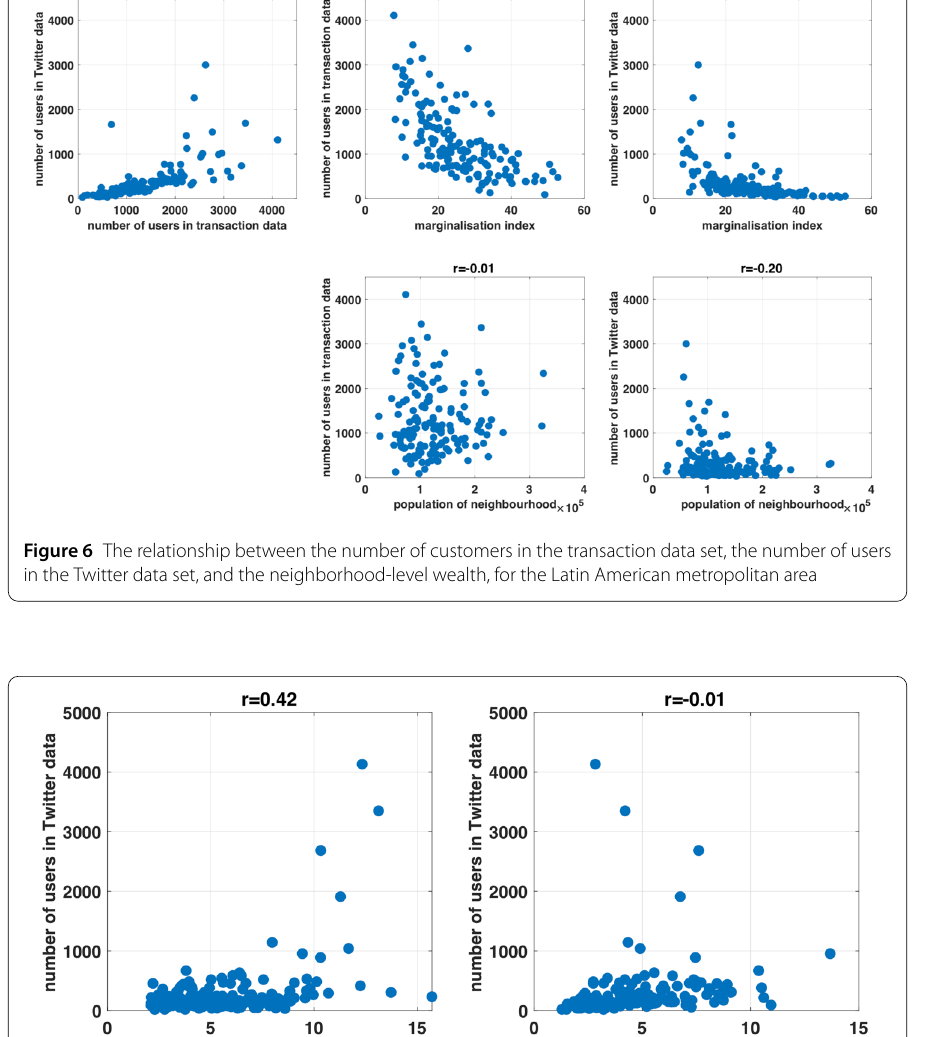
much weaker for the Latin American ( r = –0.01 and r = –0.20) and Northern American ( r = –0.01) cases, where the sampling of users is biased towards richer neighborhoods ( r = –0.64 and r = –0.53 for the Latin American case and r = 0.42 for the Northern